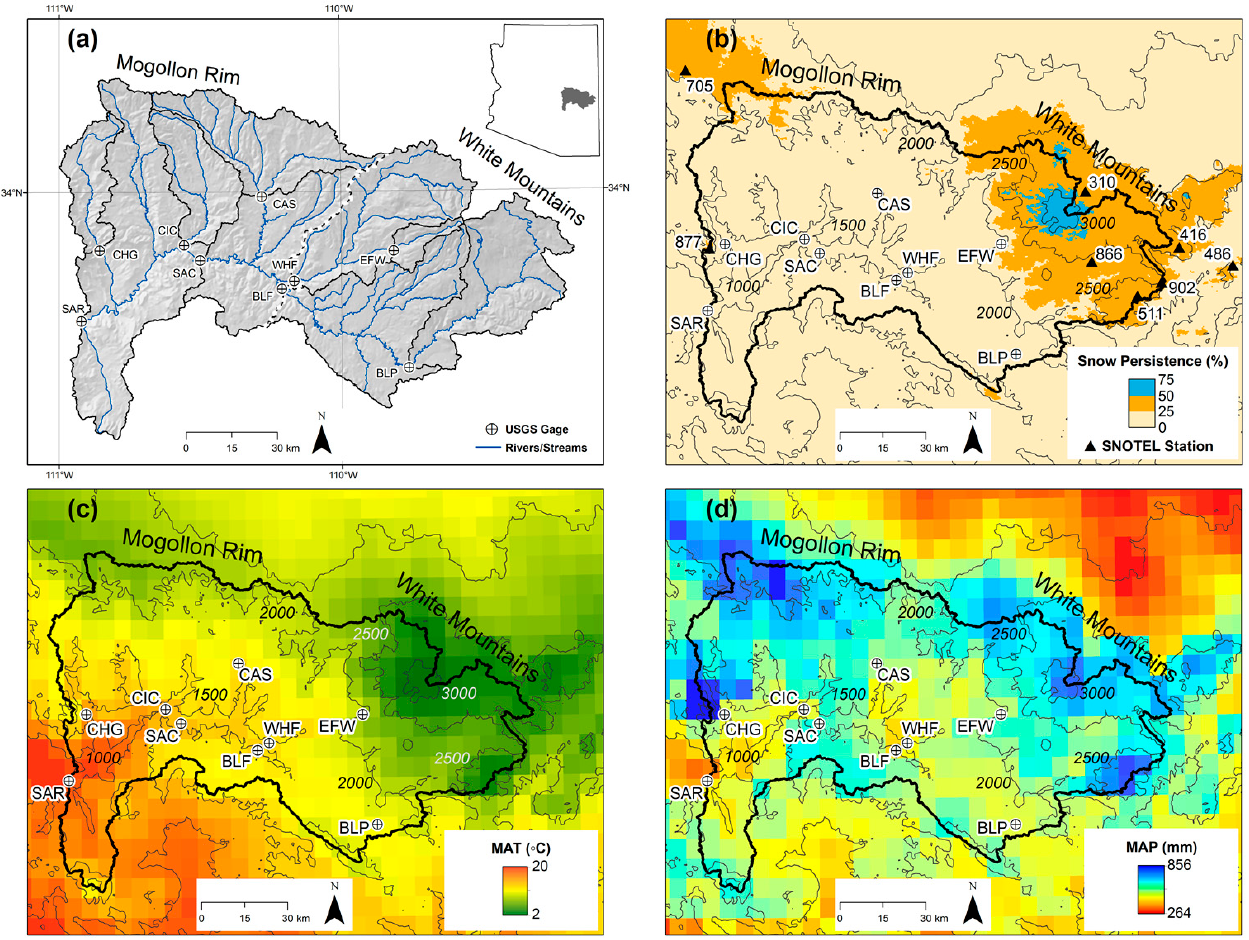
Figure 1. Salt River basin maps showing location of basins and sub-basins and USGS gages ( a ), mean annual 1 January–3 July percent snow persistence from 2001–2015 [33] and SNOTEL station numbers ( b ); mean annual temperature (MAT in °C) ( c ), and mean annual precipitation (MAP in mm) from 1929–2011 [34] ( d ). Inset in ( a ) shows study site within Lower Colorado River Basin. Dotted line within basins in ( a ) shows boundary between two sub-regions, White Mountains and Mogollon Rim; SAC and SAR gages are on the Salt River mainstem. SNOTEL station numbers shown in ( b ) correspond to station information provided in Table 2. Contour lines in ( b – d ) show elevation bands at 500 m.a.s.l. intervals .